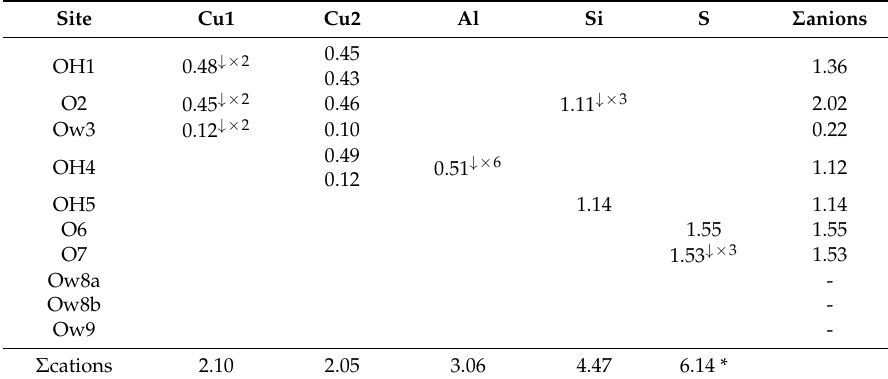
Figure 4. Bonding environment of Cu sites in tiberiobardiite. Table 6. Bond-valence sums (in valence units (v.u.)) in